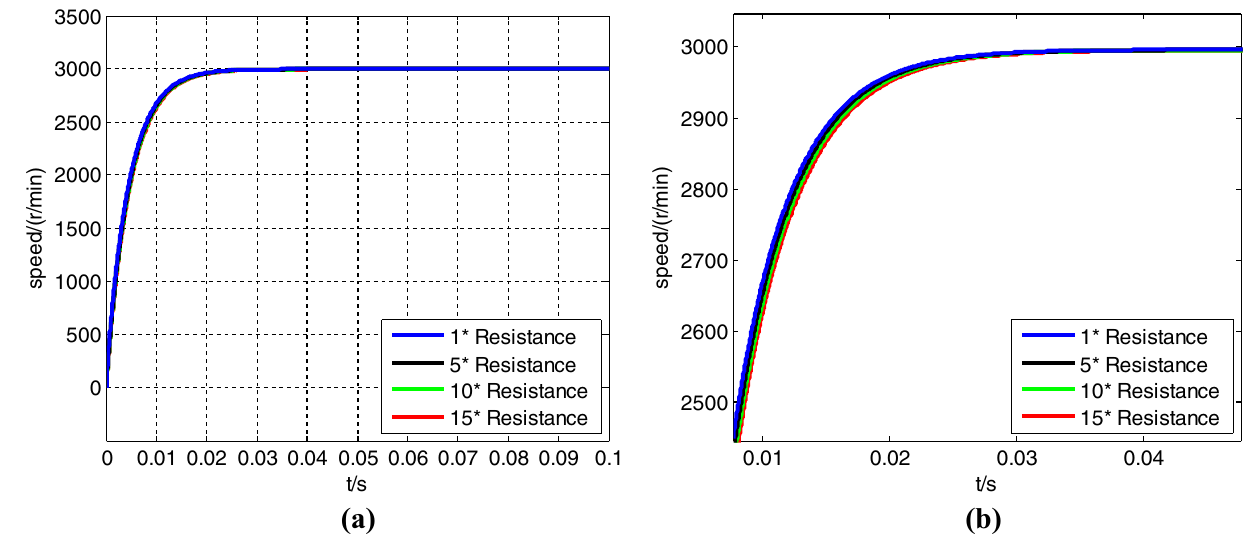
Fig. 11 The comparison of speed tracking with varying resistance: a speed response curve of 0–0.1 s, b transient speed response curve of 0–0.05 s